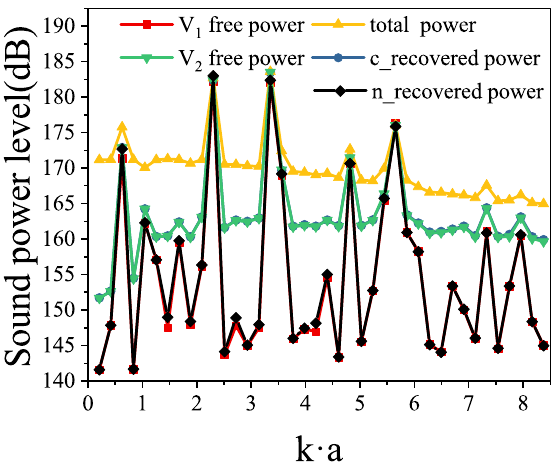
Figure 7. Sound power level on the measurement surface.